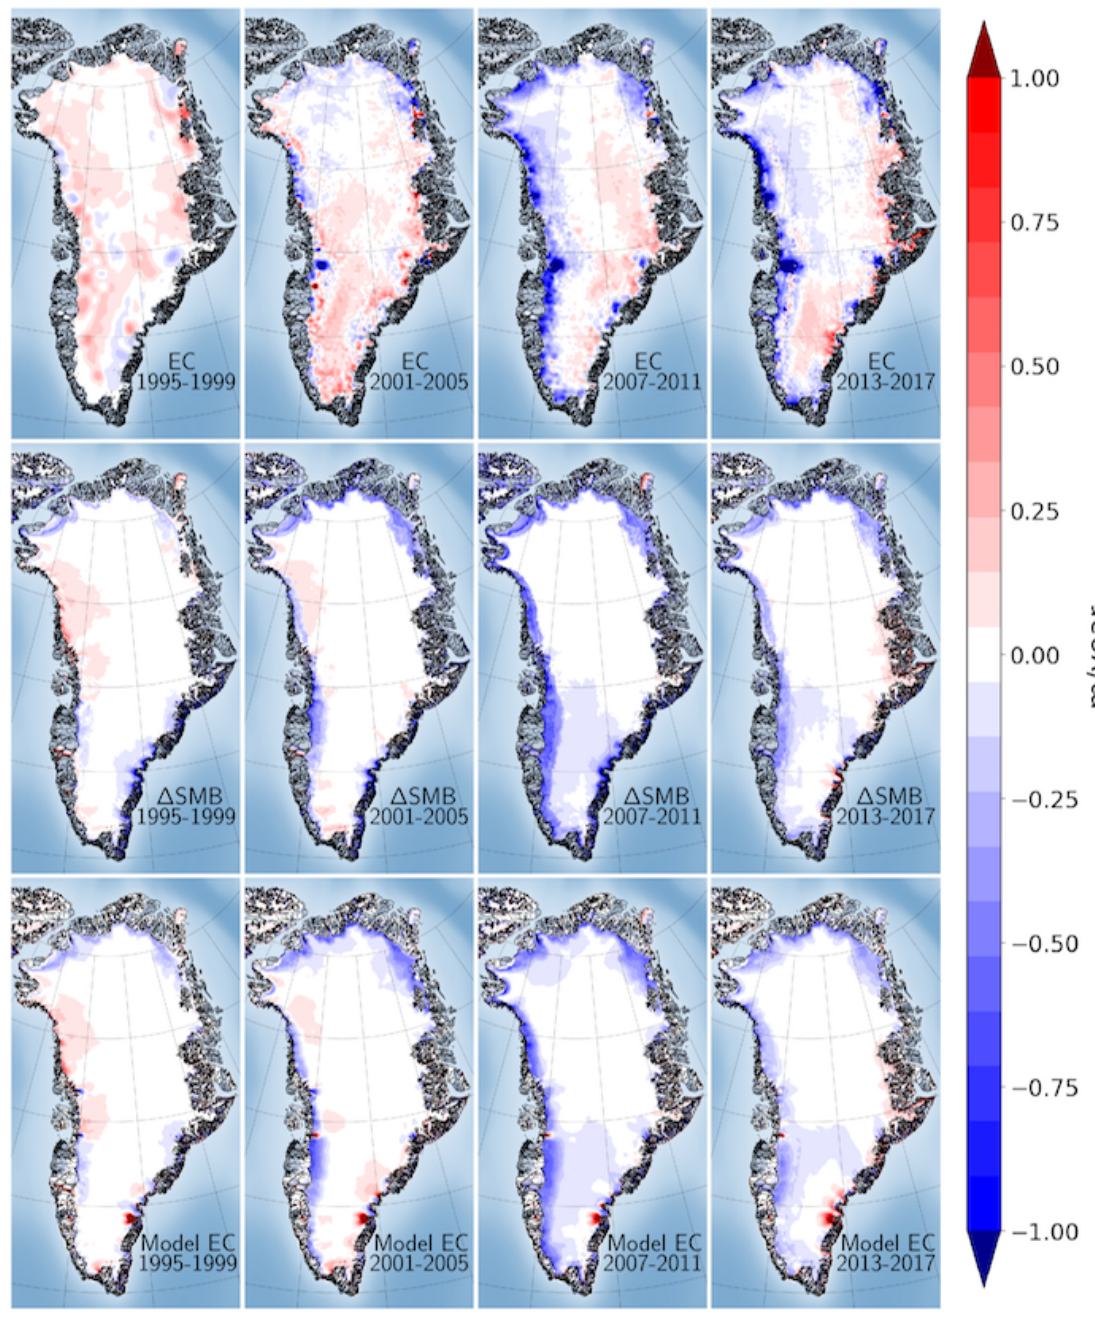
Figure 5. ( Upper panel ) Surface elevation change of the Greenland ice sheet from radar altimetry. ( Middle panel ) Change in surface mass balance with respect to the reference period (1982–1992). ( Lower panel ) Change in volume as modelled by PISM when forcing PISM with HIRHAM5 surface mass balance and